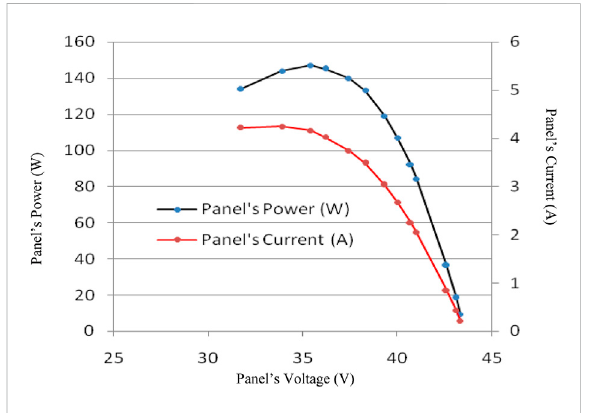
FIGURE 13 Electrical characteristics of the PV panel BP SX150S.